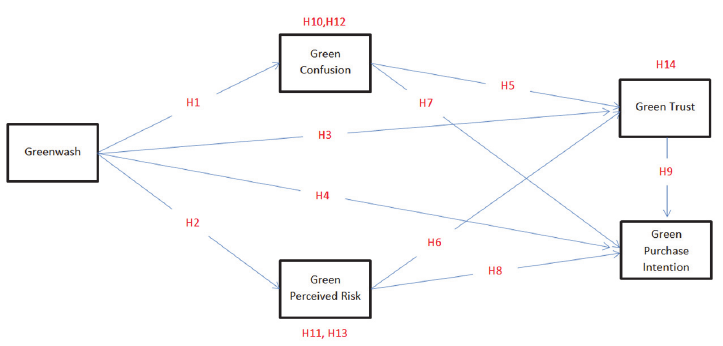
Fig. 1. Theoretical